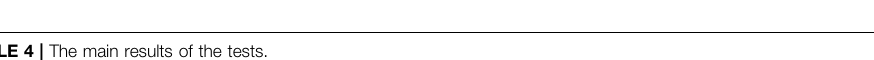
TABLE 4 | The main results of the tests.